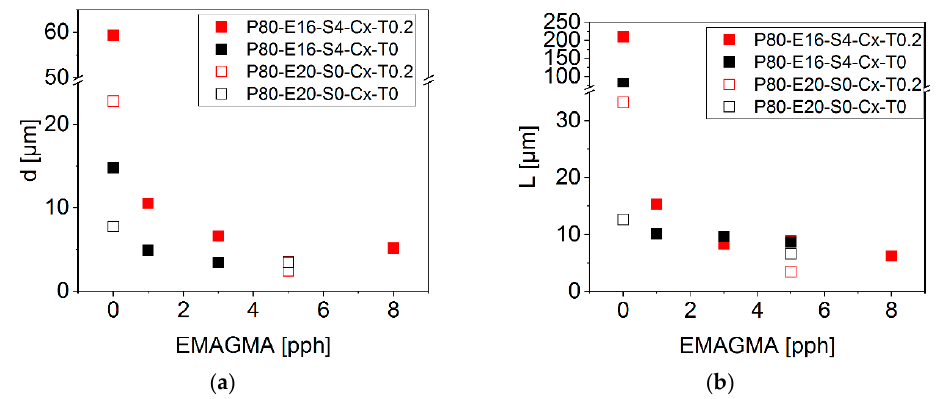
Figure 8. Results of scanning electron microscopy (SEM) analysis of the cryo-sliced blends. ( a ) Calculated values of particle size and ( b ) calculated values of inter particle distance.